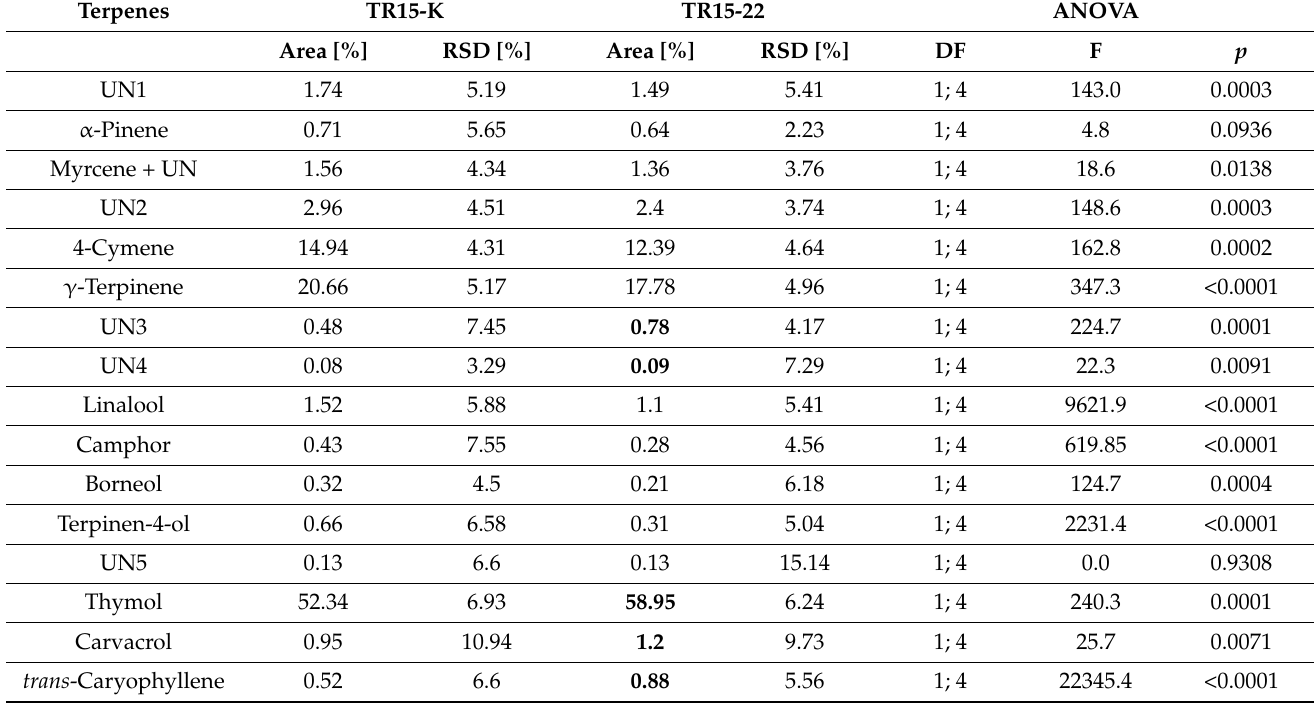
Figure 4. Principal component analysis (PCA) on relative abundances of individual terpenes in essential oil from tetraploid subclone (TR15-22) and the diploid reference subclone (TR15-K). Bor, borneol; Camp, camphor; Carv, carvacrol; α -Pin, a-pinene; t -Car, trans -caryophyllene; 4 -Cym, 4 - cymene; Lin, linalool; Myr + UN, myrcene + UN; γ -Ter, g-terpinene; T-4-ol, terpinen-4-ol; Thym, thymol; UN1-5, unknown compound 1-5.